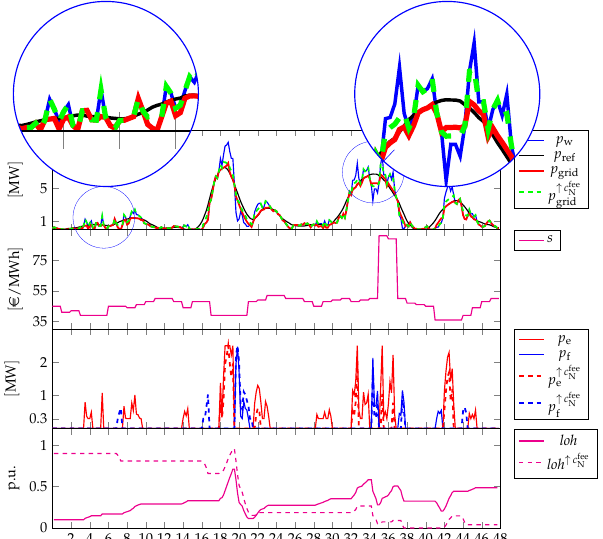
Figure 13. Different profiles related to the reference period from 09:00 of Mon 29 th May, 2017 to the same hour of Tue 30 th May, 2017, with full-feature operations: c fee N = 0.2 vs. c fee N = 3. First graph: powerbywindgeneration(bluesolidline),powerreferencethathastobedeliveredtothe grid (black solid line), actual power delivered when c fee N = 0.2 (red solid line) and actual power deliveredwhen c fee N = 3(greendashedline);Secondgraph: spotmarketprices s (source: “Gestore deiMercatiEnergeticis.p.a. —www.mercatoelettrico.org”);Thirdgraph: poweroftheelectrolyzer when c fee N = 0.2(redsolidline),powerofthefuelcellwhen c fee N = 0.2(bluesolidline),powerofthe electrolyzerwhen c fee N = 3(reddashedline)andpowerofthefuelcellwhen c fee N = 3(bluedashed line); Fourth graph: LoH when c fee N = 0.2 (magenta solid line) and LoH when c fee N = 3 (magenta dashedline).